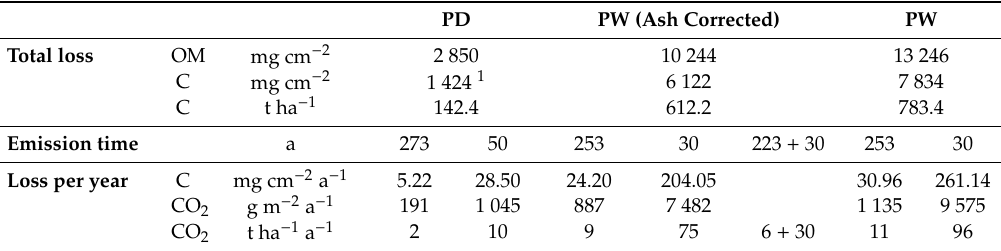
Table 3. Losses of OM, C, and CO 2 at PD and PW.